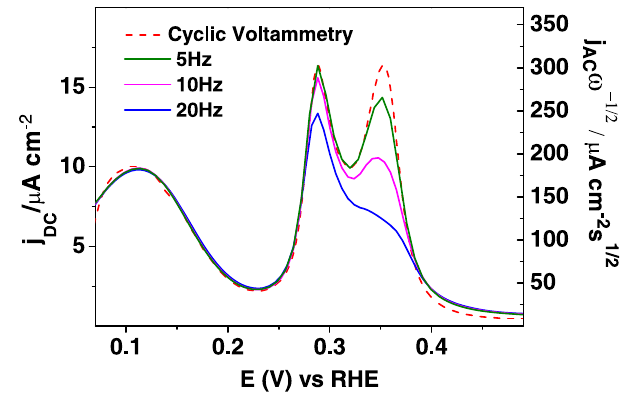
Fig. 3 AC voltammetry on Pt(311). AC voltammetry and cyclic voltammetry for different frequencies on a Pt(311) at 10 mV/s.